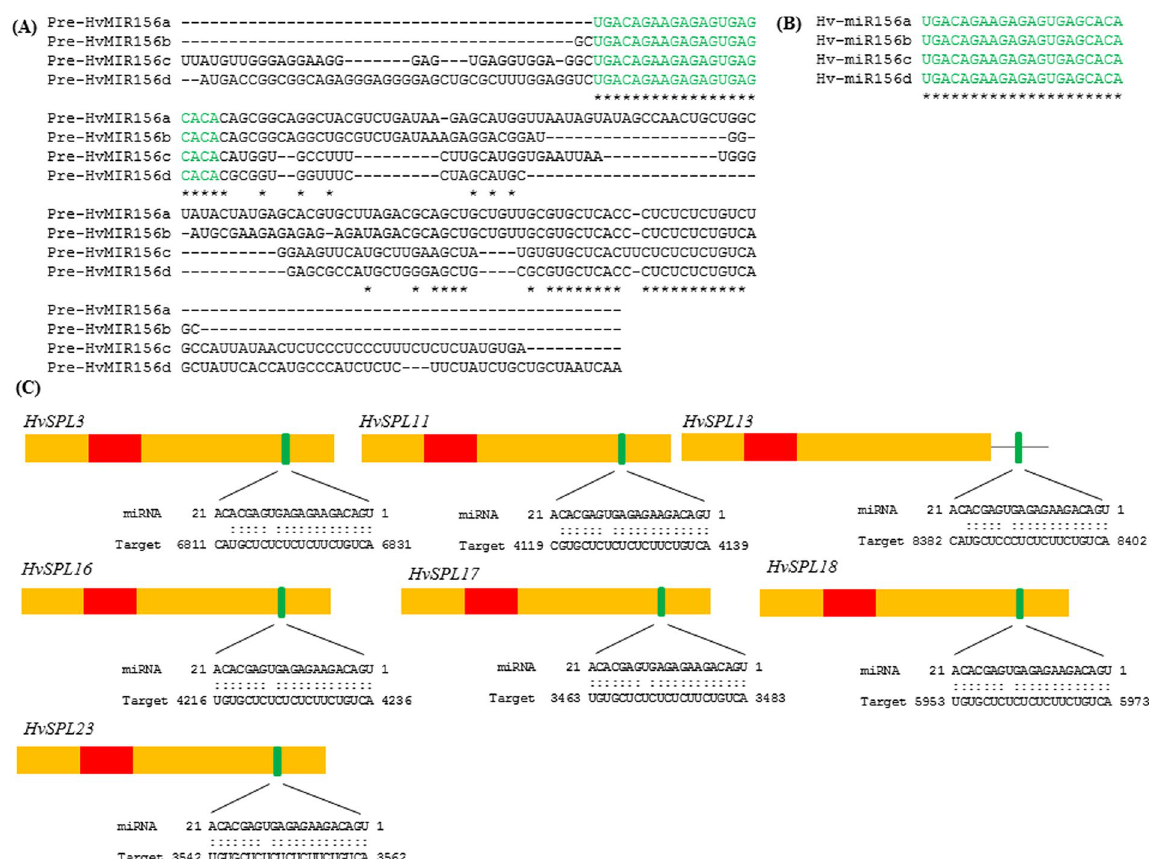
Figure 2. miR156 family members and their target site in Barley SPL genes. ( A ) Alignment of precursor sequences of four miR156 family members. ( B ) Alignment of mature sequences of four miR156 family members. Green colour denotes the mature sequence of miR156a/b/c and d. ( C ) miR156 target site in HvSPL3, 11, 13, 16, 17, 18 & 23 genes. Yellow box represent CDS, red box SBP domain and line 3 ′ UTR. The miR156 target sites with the nucleotide positions of HvSPL transcripts are shown in green. RNA sequence of each complementary site from 5 ′ to 3 ′ and the predicted miRNA sequence from 3 ′ to 5 ′ are